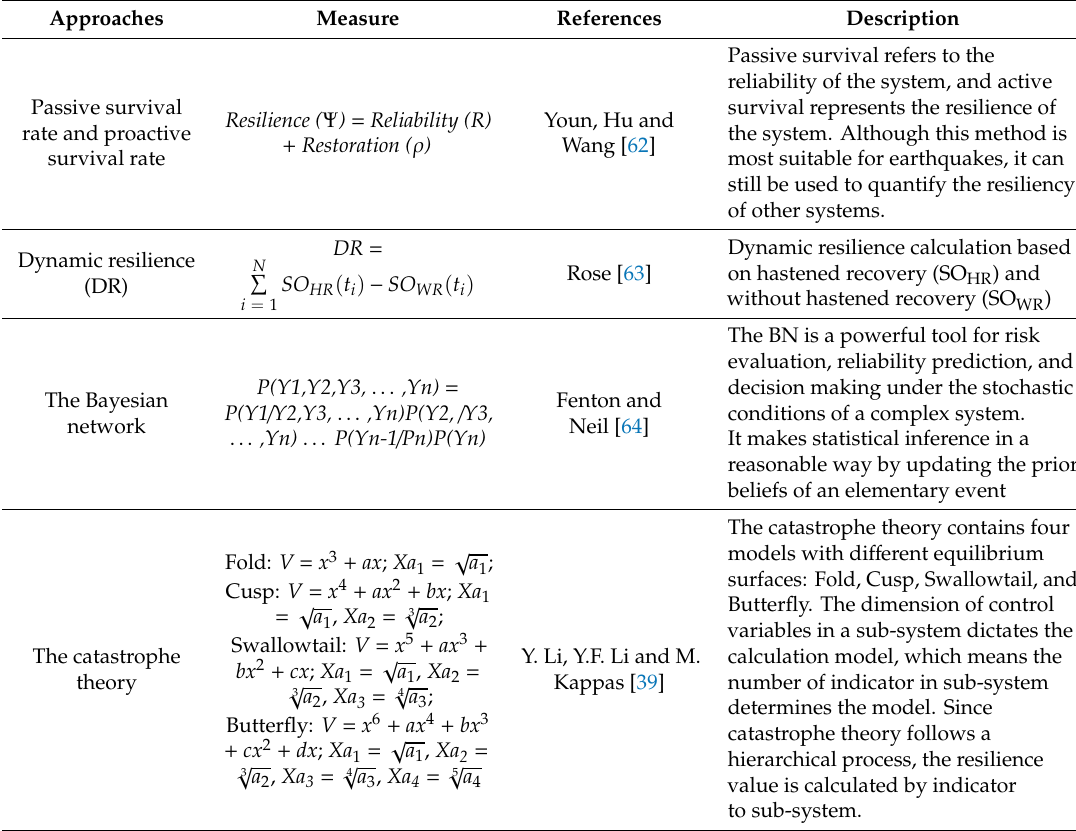
Table 3. Di ff erent techniques for quantifying and modelling